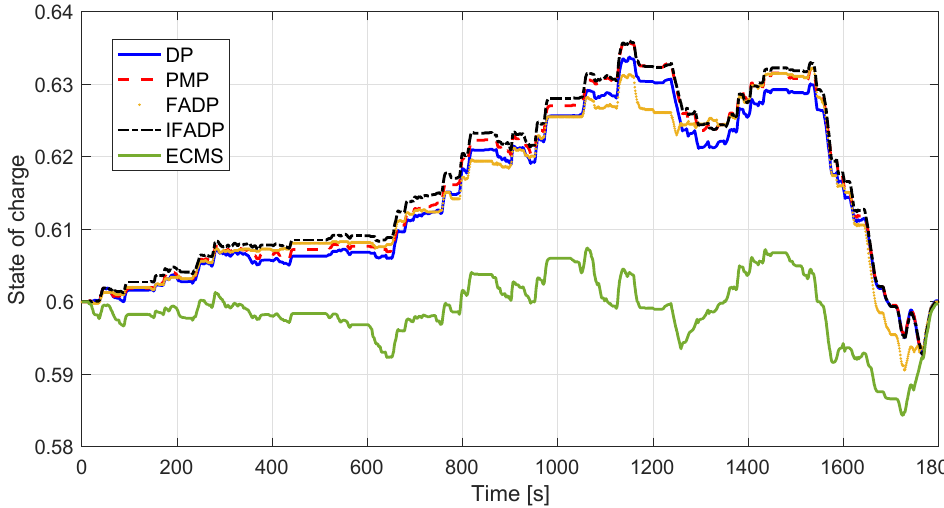
Figure 9. State of charge trajectories through the presented ECMS-based technique (green line) compared to those of DP (blue line), PMP (red dashed line), FADP (dotted line) and IFADP (dot-dashed line) approaches on the WLTP driving cycle. Table 5. Results of Causal ECMS-based ( Q = 1000), applied to the driving cycles listed in Table 2 in terms of Relative Fuel Economy